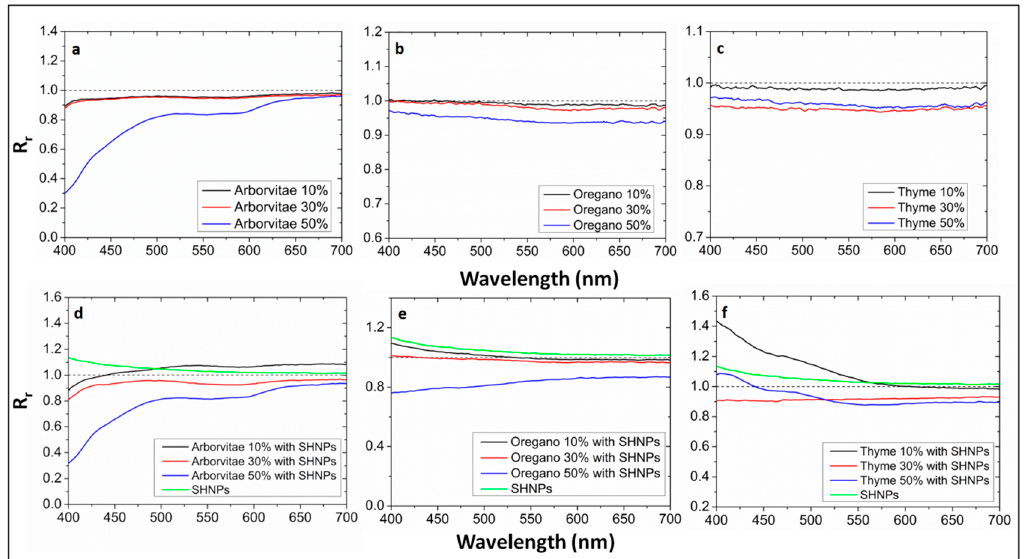
Figure 2. Dependence of the reflectance ratio R r as a function of wavelength for sandstone samples. ( a ) 10%, 30%, 50% Arborvitae EO; ( b ) 10%, 30%, 50% oregano EO;.( c ) 10%, 30%, 50% Thyme EO; ( d ) 10%, 30%, 50% Arborvitae EO with SHNPs; ( e ) 10%, 30%, 50% Oregano EO with SHNPs; ( f ) 10%, 30%,